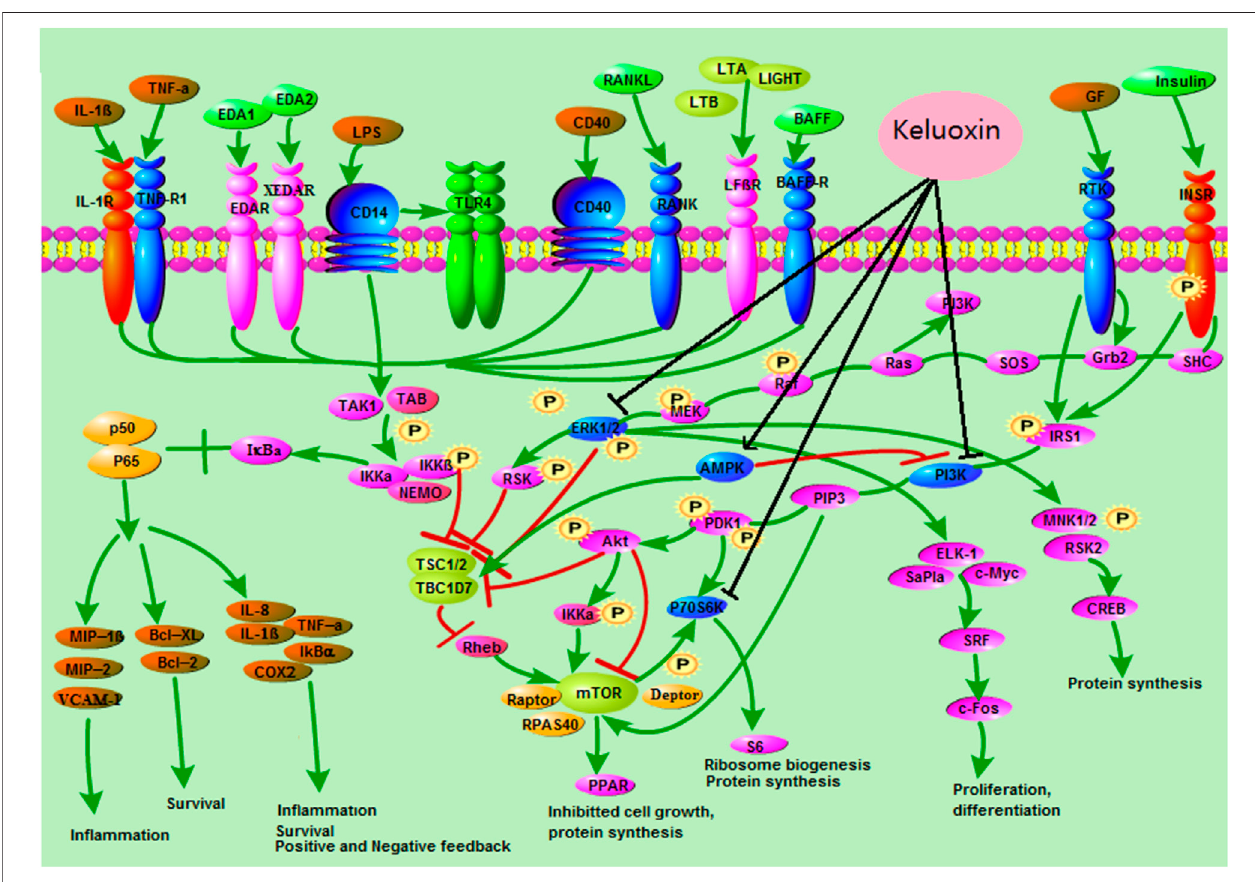
FIGURE 7 | Core targets and signaling pathways of KLX ’ s regulation of DR. KLX could inhibit ERK1/2, PI3K, and p70 S6K and activate MAPK to in fl uence the MAPK signal transduction, mTORC1 signaling, and NF- κ B signaling pathways, which delayed the progression of DR. KLX, keluoxin; DR, diabetic retinopathy.